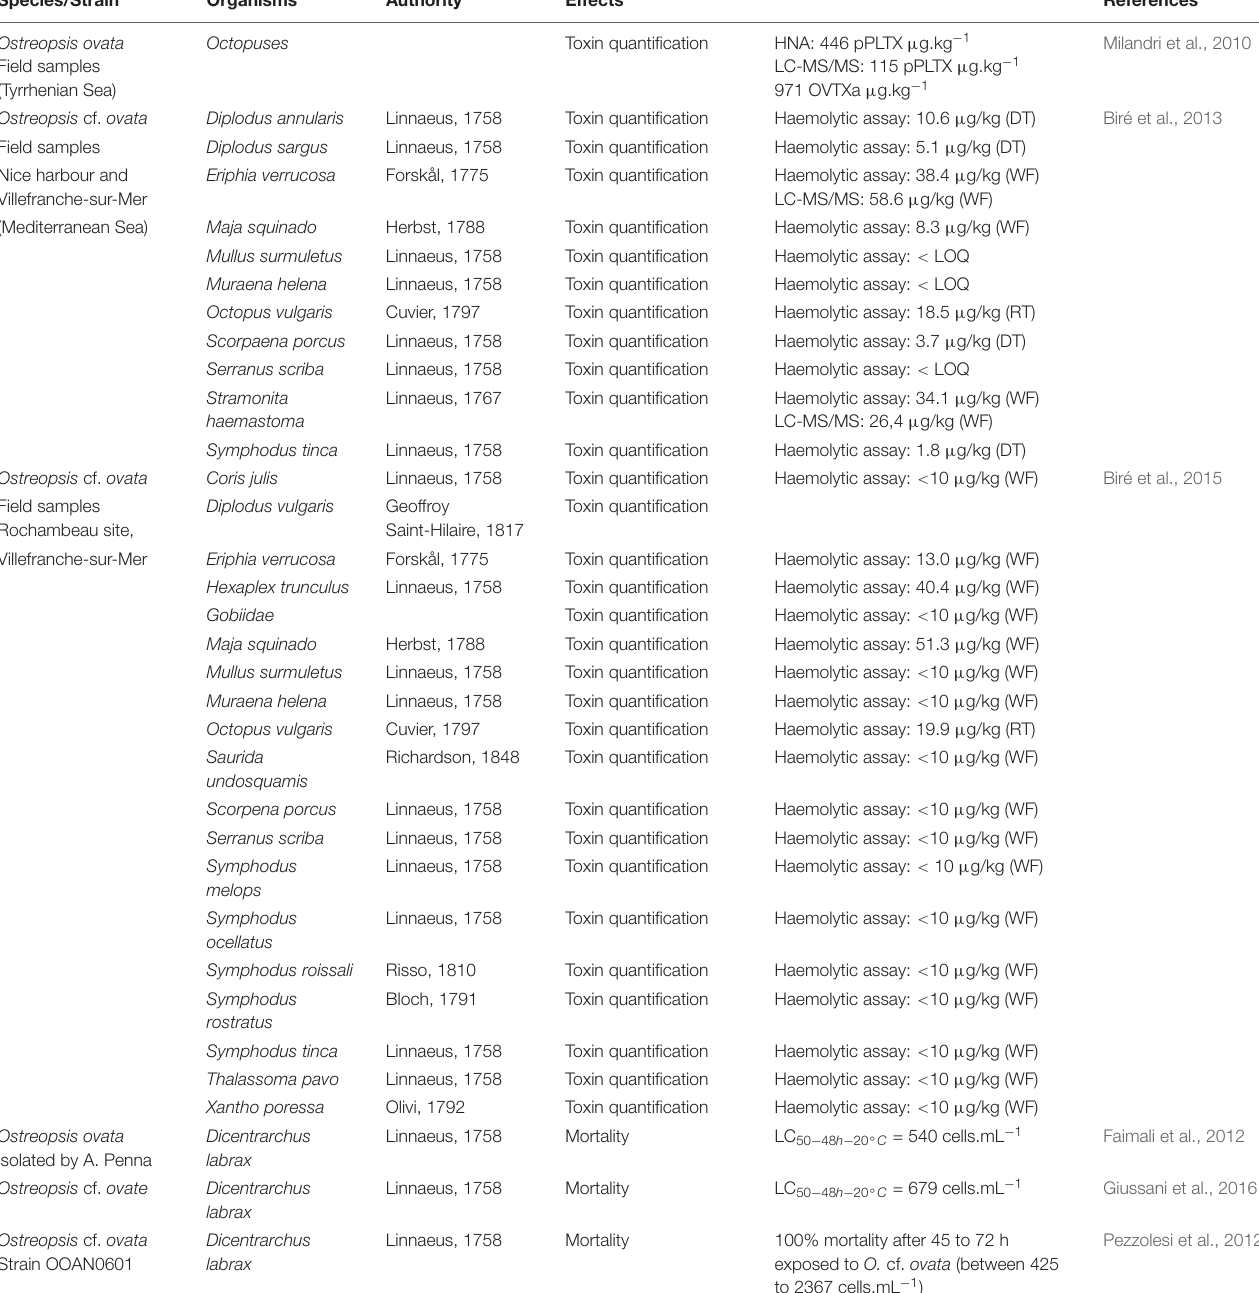
TABLE 4 | Effects on organisms exposed indirectly to Ostreopsis